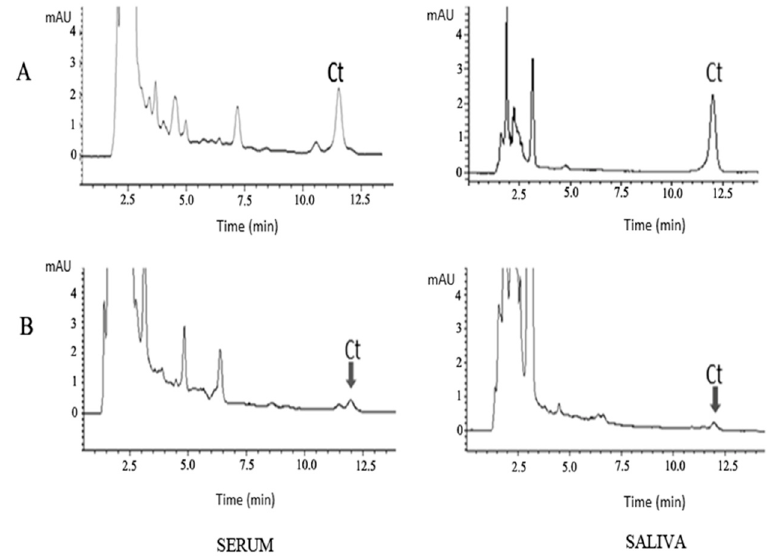
Figure 7. Chromatograms obtained for cytisine (Ct) on Luna 5 µ m, SCX 100A, 150 × 4.6 mm column with mobile phase containing 15 % ACN and 100 mM of formate buffer at pH 4.0 in serum and saliva samples: ( A ) spiked with 100 ng/mL of cytisine, ( B ) samples from patients treated with drug. Samples were collected 2 h after single oral dose administration of 4.5 mg (saliva) or 1.5 mg (serum).